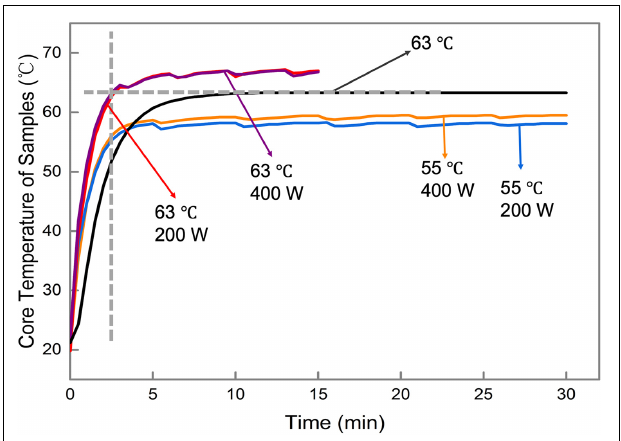
FIGURE 2 | Core temperature changes of samples under different treatment conditions. The black line shows the temperature change without ultrasonic